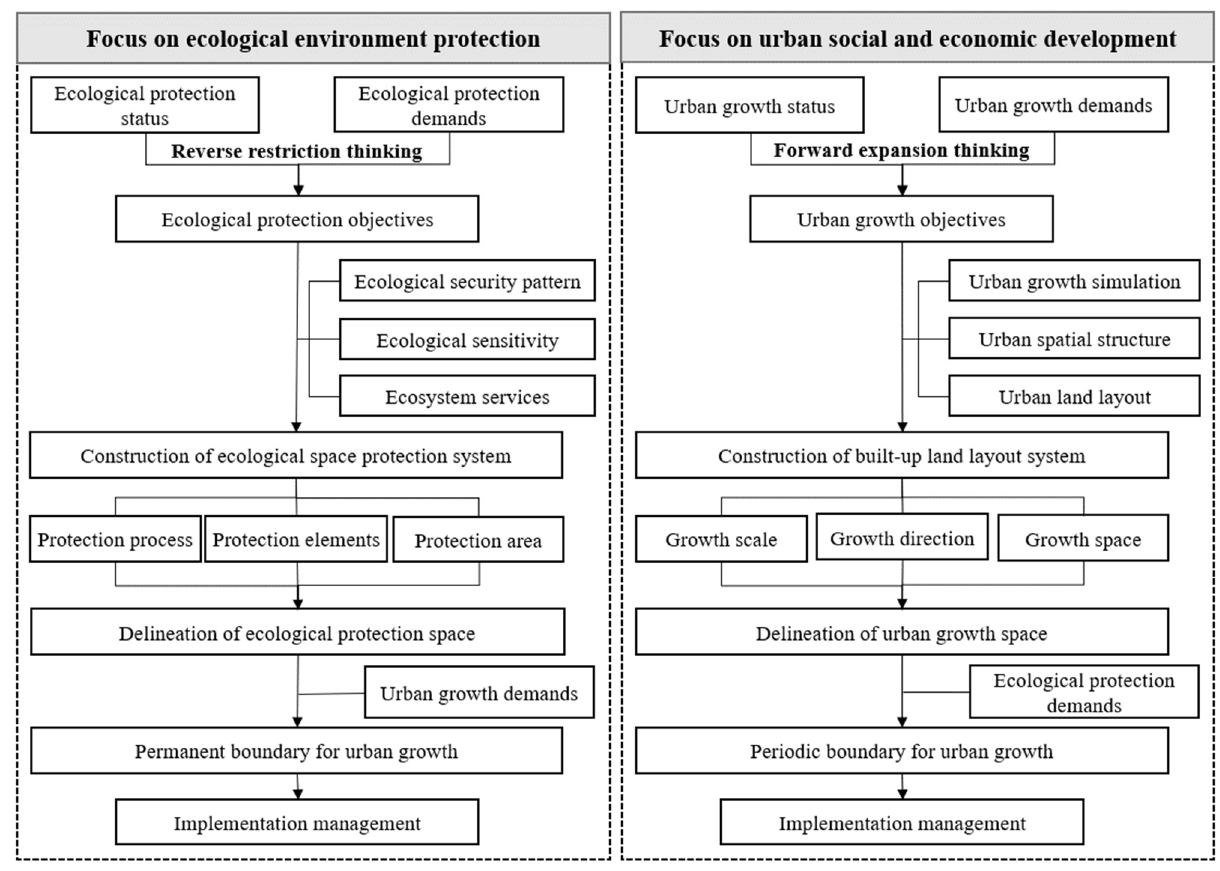
Figure 6. “Reverse limiting thinking” ( left ) and “Forward expansion thinking” ( right ) delineate the technical process of urban growth boundary.